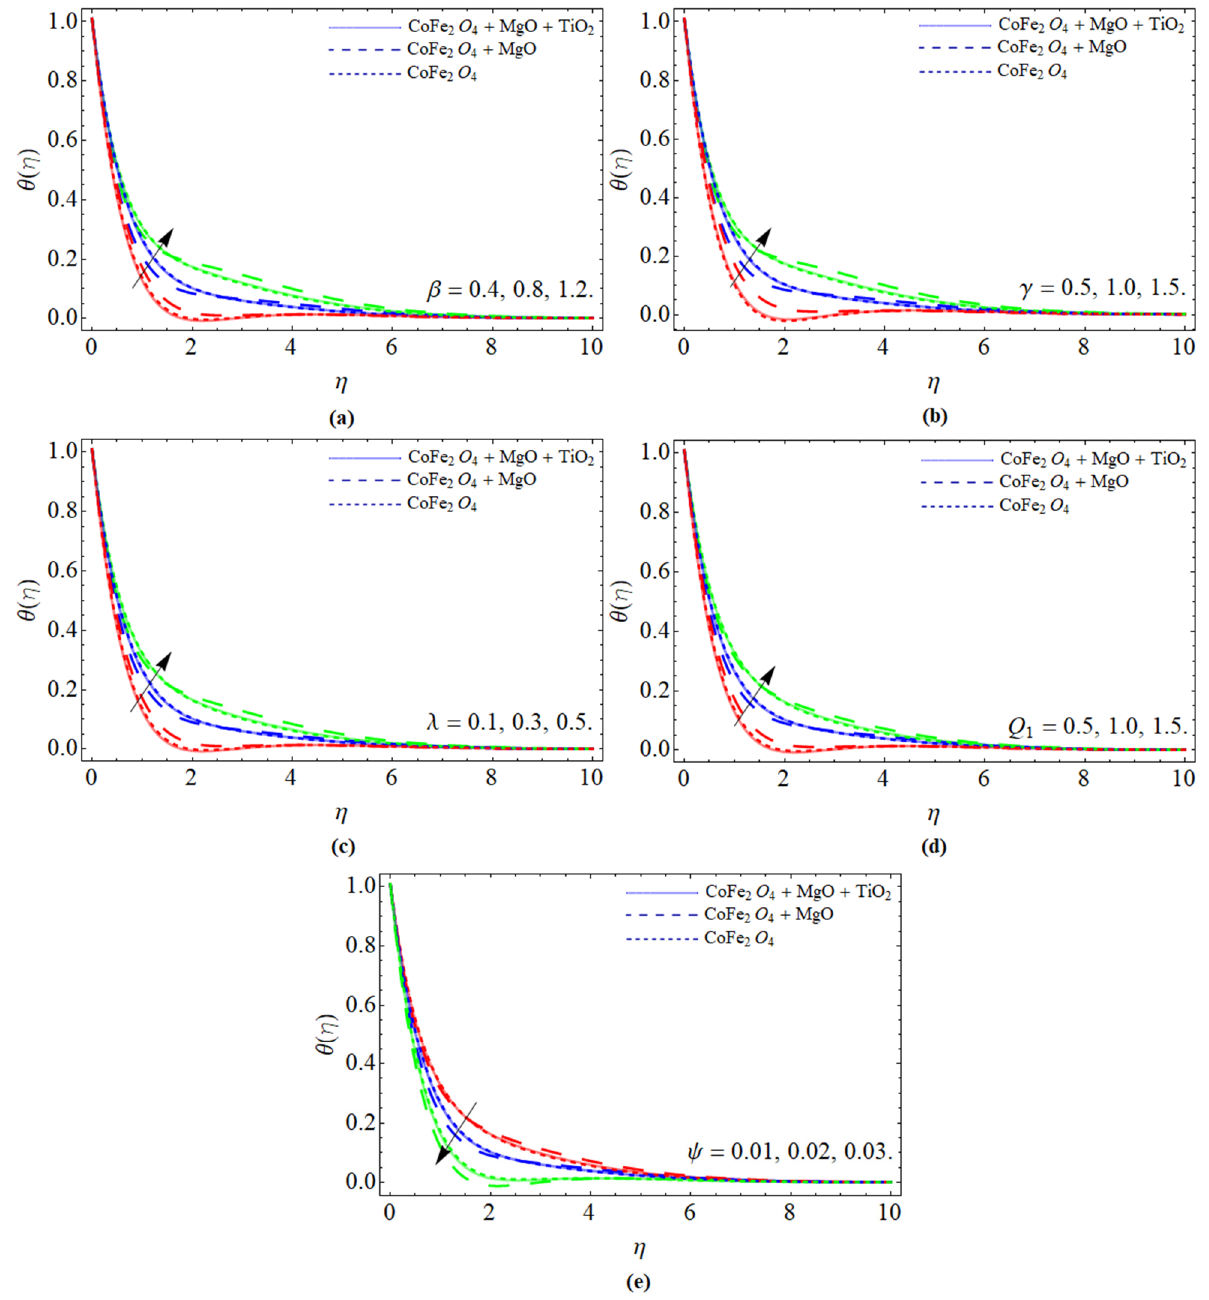
Figure 4. The presentation of energy θ ( η ) profile against the variation of ( a ) magnetic term β , ( b ) curvature constant γ , ( c ) inverse magnetic Prandtl number λ , ( d ) heat source Q 1 , and ( e ) nanopar- ticles volume friction ψ